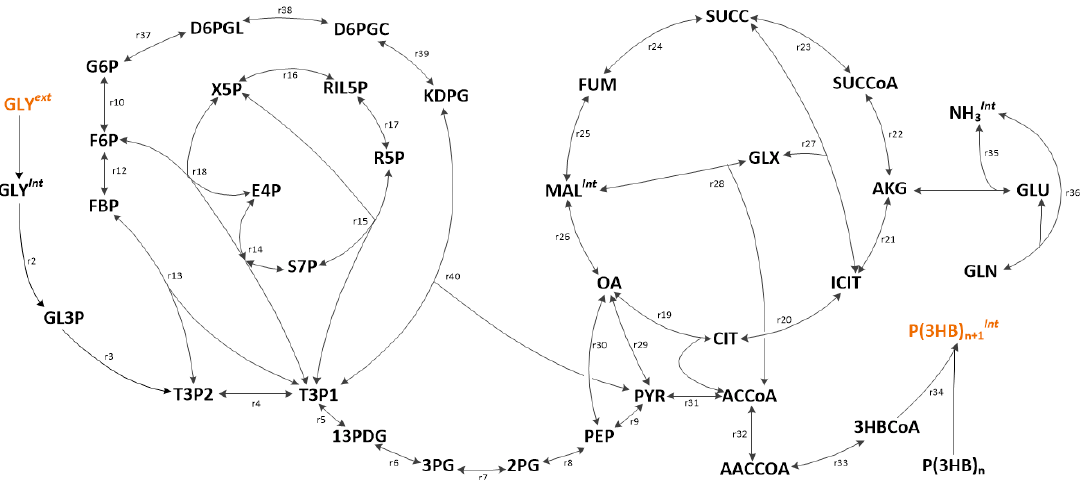
Figure 1. Metabolic map of C. necator DSM 545. Only pathways associated with central carbon metabolism are shown, while the remaining ones (such as most transport pathways) were omitted from the figure for clarity of the layout .